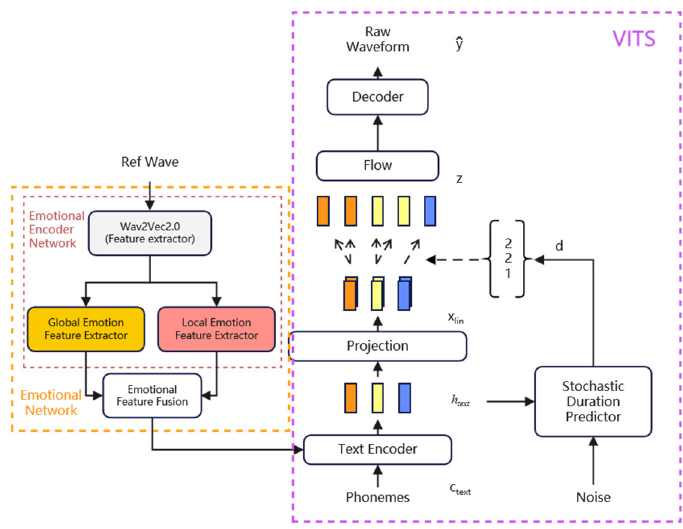
Figure 4. Inference procedure of Emo-VITS.